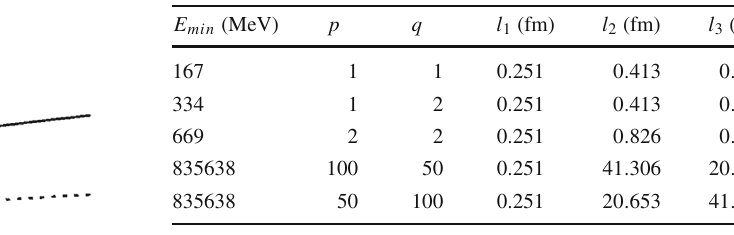
Table 1 Minimum of the energy for values of p and